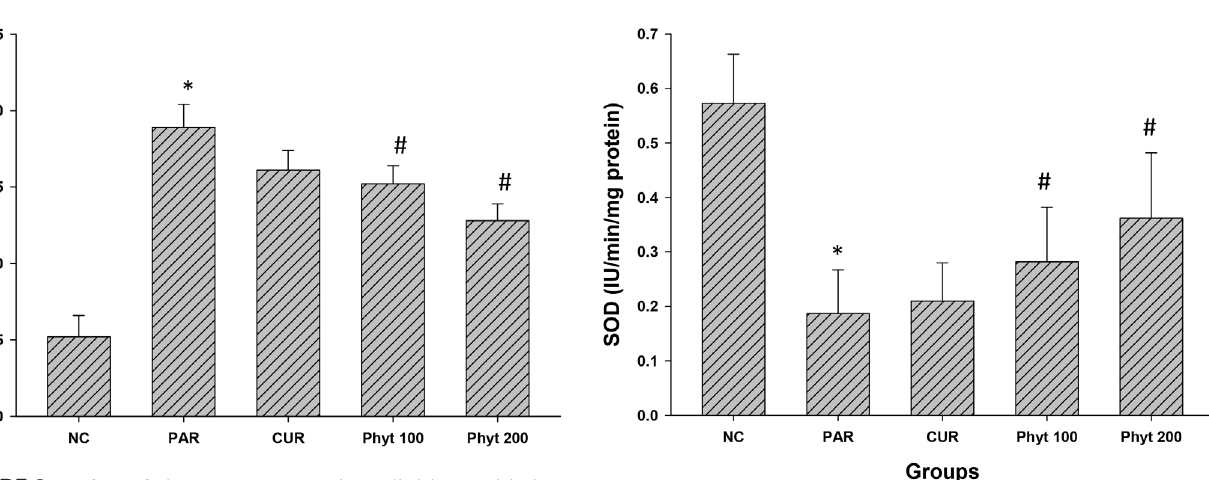
FIGURE 8 - Effect of phytosome curcumin on lipid peroxidation of control and treated animals in paracetamol-induced liver injury in mice. NC: Control group; PAR: mice received 1g/ kg b.w of Paracetamol; CUR: mice received 200 mg/kg b.w